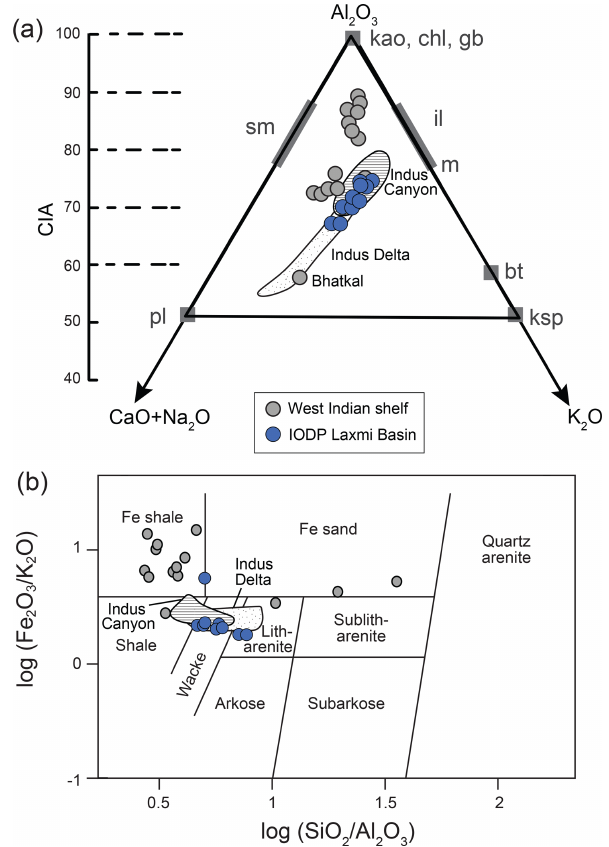
Figure 3. (a) Geochemical signature of the analyzed samples illus- trated by a CN-A-K ternary diagram (Fedo et al., 1995). CN denotes the mole weight of Na 2 O and CaO* (CaO* represent the CaO asso- ciated with silicate, excluding all the carbonate). A and K indicate the content of Al 2 O 3 and K 2 O, respectively. Samples closer to A are rich in kaolinite, chlorite, and/or gibbsite (represented by Kao, Chl, and Gib). CIA values are also calculated and shown on the left side, with its values correlating with CN-A-K. Samples from the delta have the lowest values of CIA and indicate high contents of CaO and Na 2 O and plagioclase. Abbreviations: sm (smectite), pl (plagioclase), ksp (K-feldspar), il (illite), m (muscovite). (b) Geo- chemical classification sediments from the Indus Delta (Clift et al., 2010), Indus Canyon (Li et al., 2018), and western Indian Peninsula